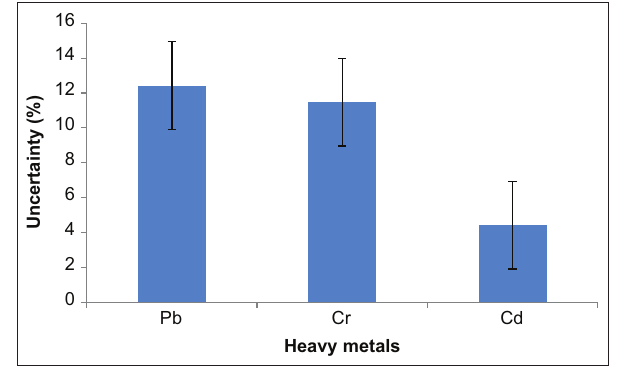
Figure-1: Uncertainty percentage (mean ± SE) of measured heavy metals in poultry